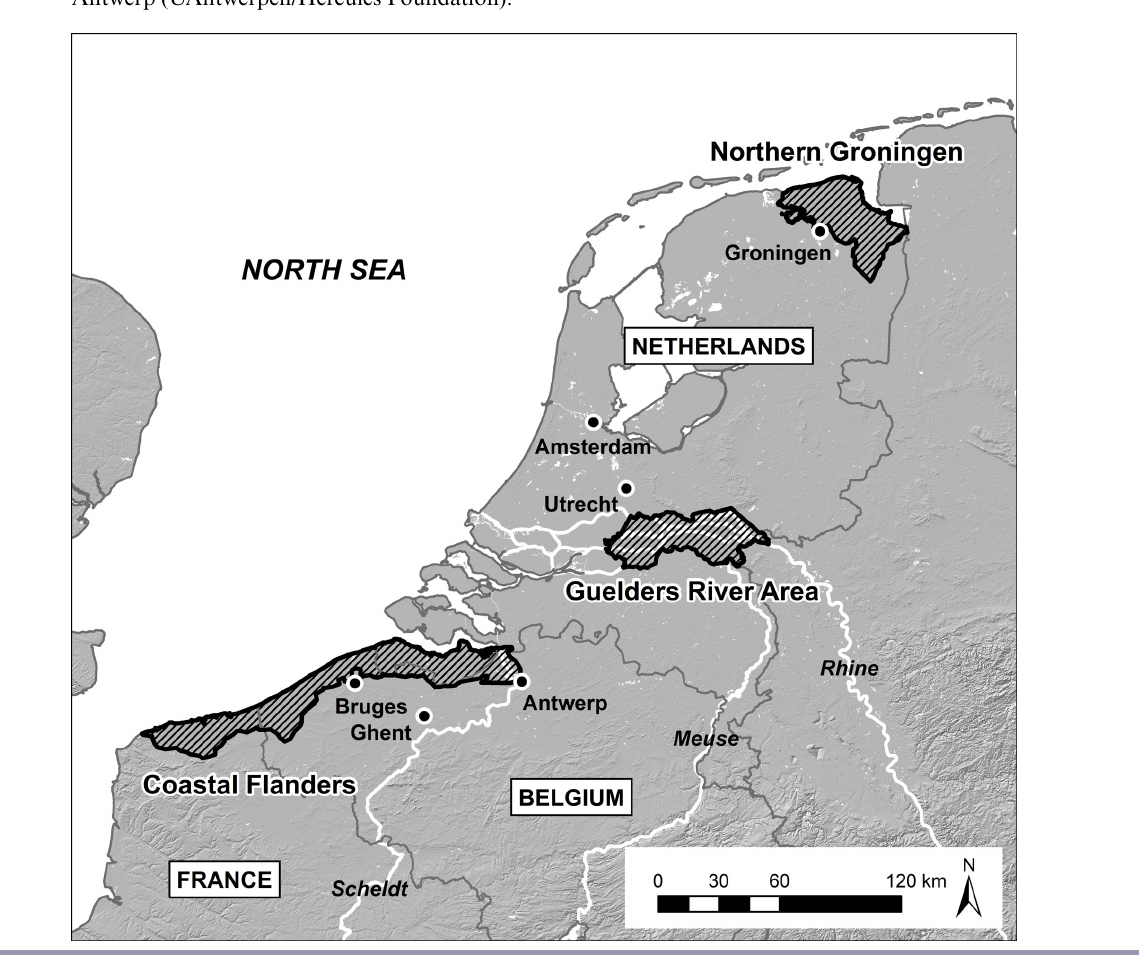
Fig. 1 . Map of the Low Countries indicating the three regions. Iason Jongepier, GIStorical Antwerp (UAntwerpen/Hercules